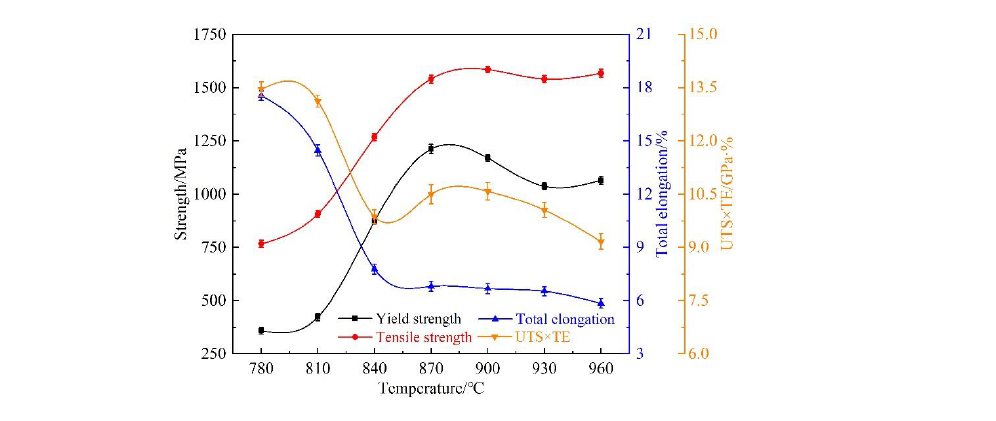
Figure 10. The strength, elongation and UTS × TE variations at different austenitizing temperatures. The elongation of 22MnB5NbV decreases with the increase in the austenitizing tem- perature. The highest elongation is 17.6% at 780 °C, which is nearly 10.0% lower than the original steel ’ s elongation at 27.4%. This is due to the transformation of some pearlite and ferrite into austenite in the austenitizing process, and then the transformation of austenite